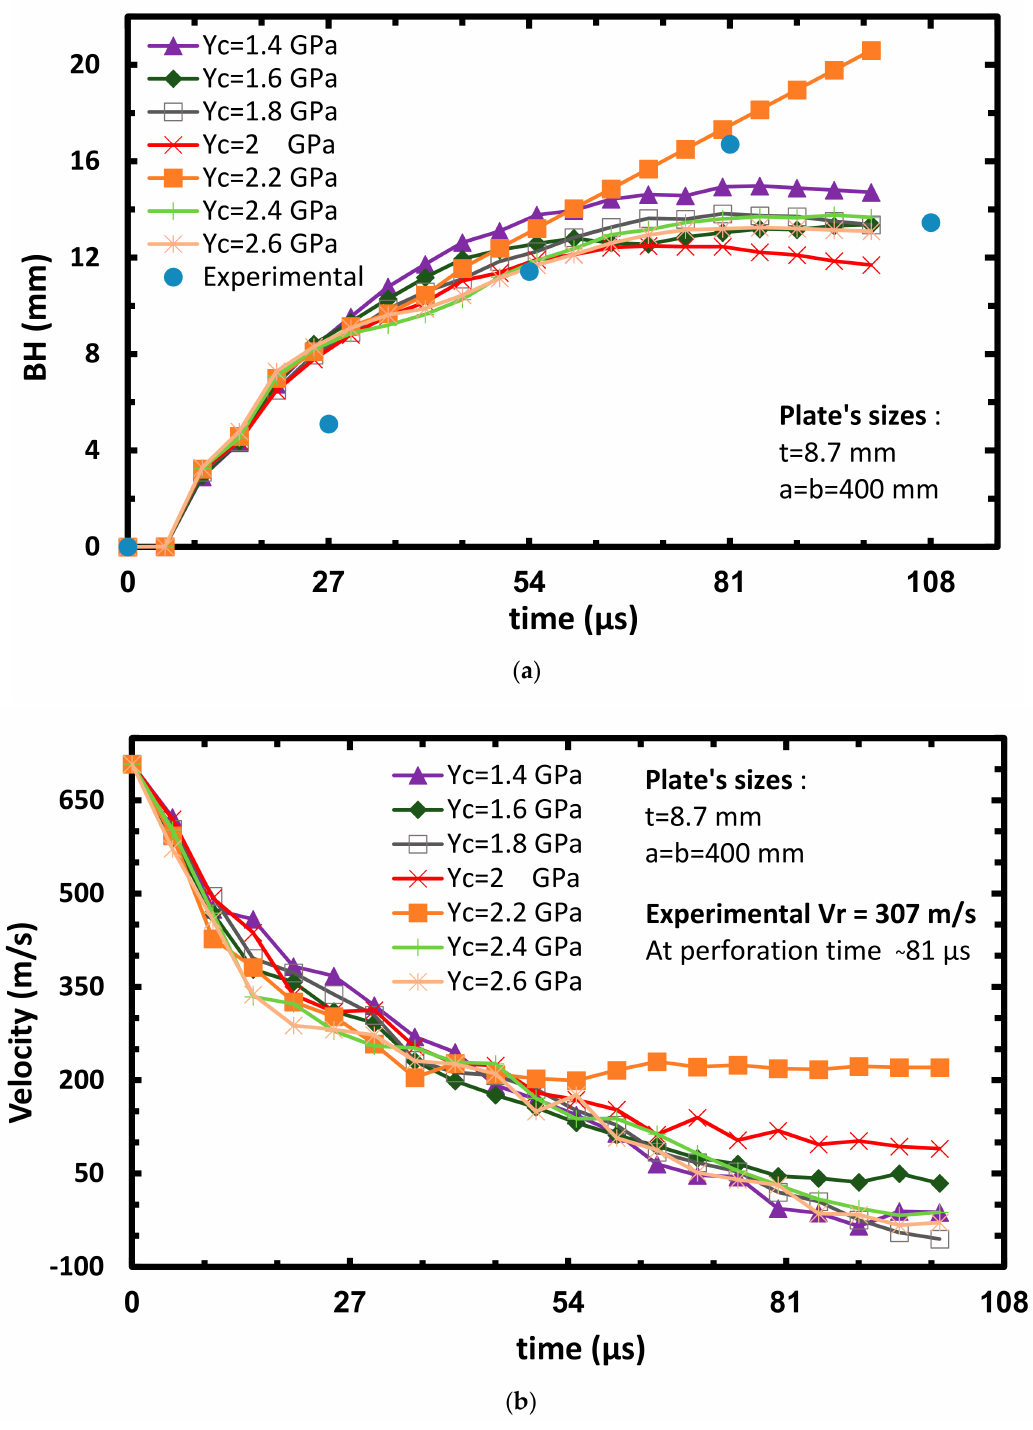
Figure 9. Plate’s bulge height ( a ) and projectile’s velocity ( b ) vs. time at varying Yc, Vinitial = 708